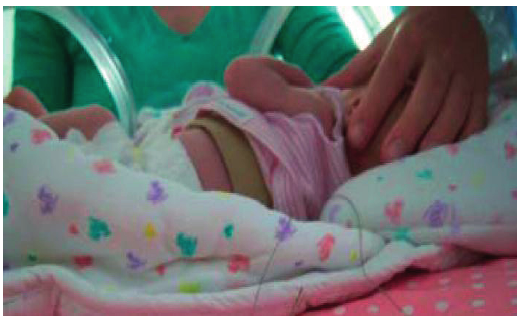
Figure 7. User testing on an infant in the NICU [10]. Copyright © 2010 Association for Computing Machinery,